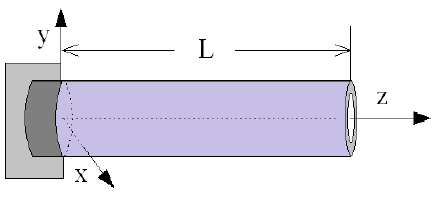
Figure 1. Boring bar model.